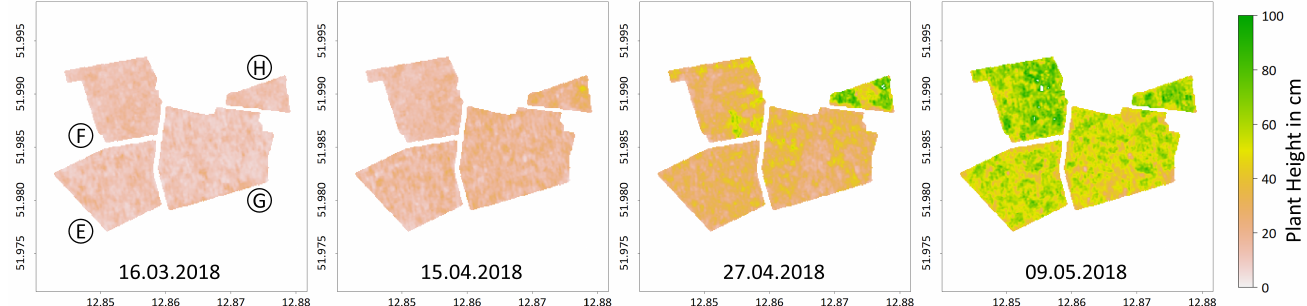
Figure 13. Plant heights of four dates during BBCH stages 21–49 in 2018 estimated by multiple exponential regression for the Blönsdorf fields E and G (wheat) and F and H